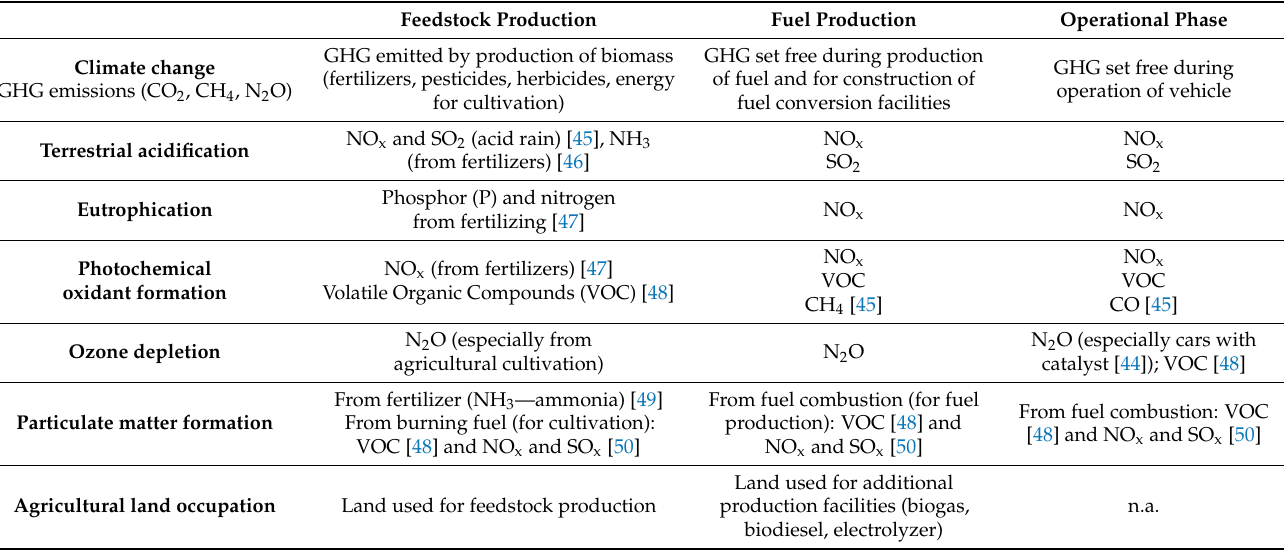
Table 4. Environmental criteria for a well-to-wheel analysis.